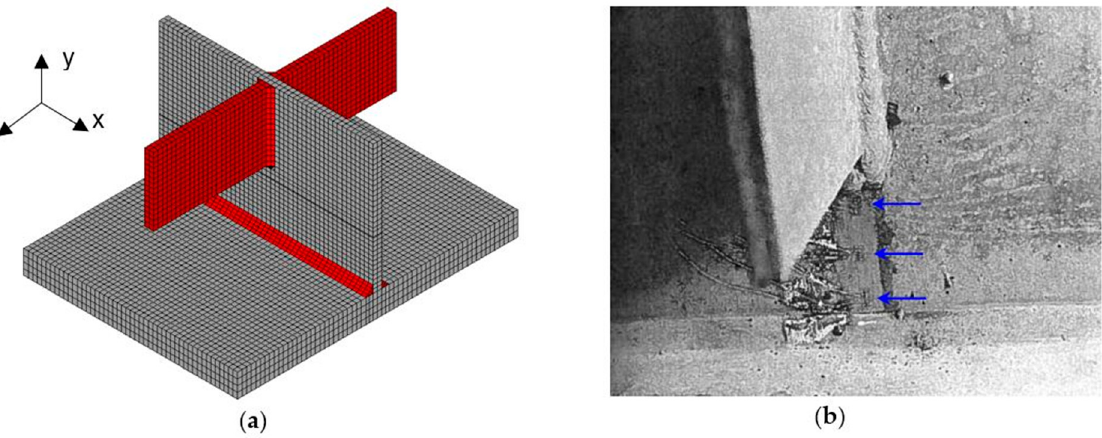
Figure 9. ( a ) Local numerical models of the web gap detail: 76 mm web gap and ( b ) placement of strain gauges to measure the modified hot-spot stresses [47].